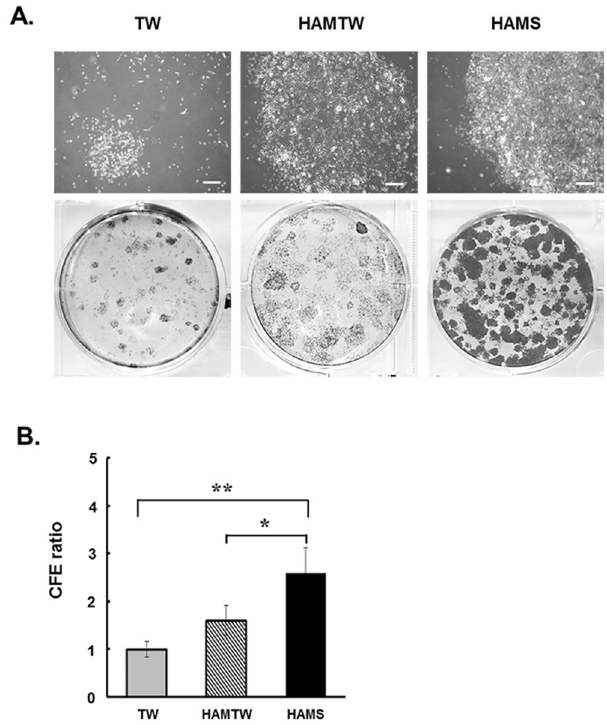
Figure 4. CFE from limbal explant outgrowth sheets cells on substrate free, HAMTW, and HAMS. ( A ) Phase contrast micrographs and Coomassie blue stained holoclone colonies from limbal explant outgrowth sheets in CNTP media. ( B ) CFE ratio normalized to TW. Data are from six independent experiments. * p < 0.05, ** p < 0.01 (n = 6 from 3